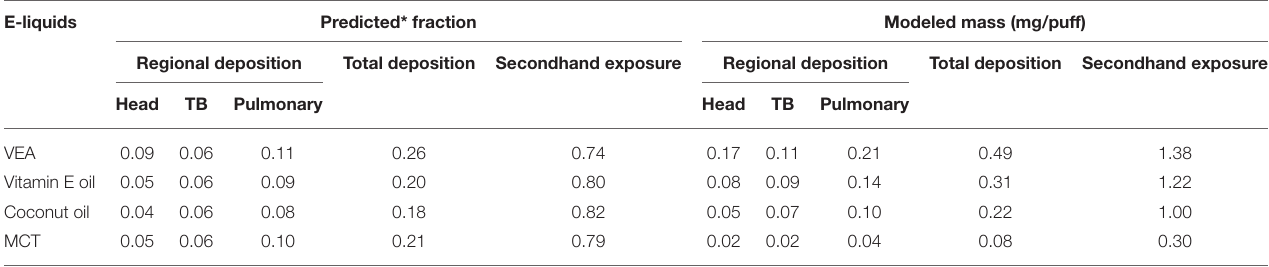
TABLE 1 | Predicted * deposition fraction and modeled doze deposition for